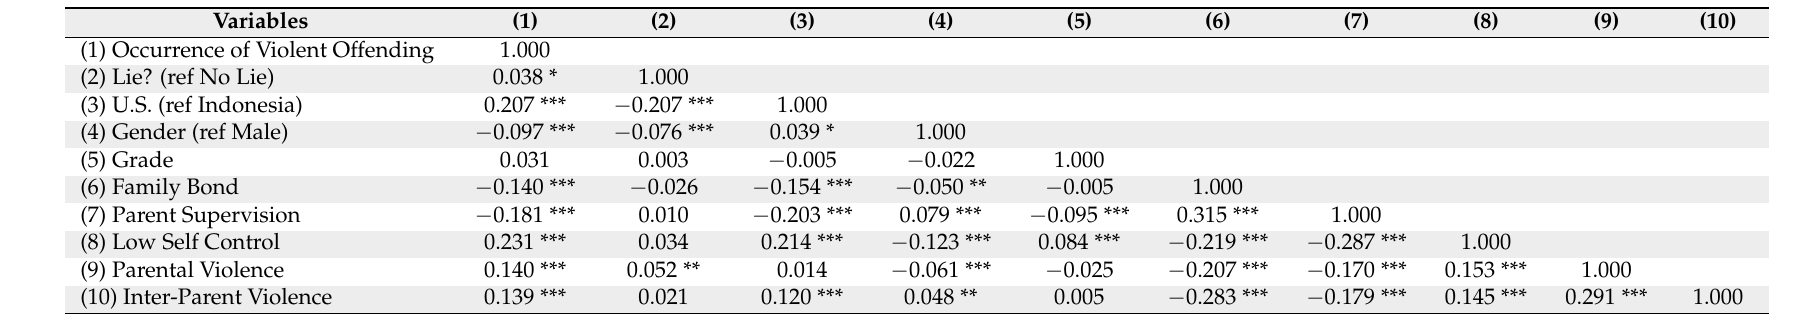
Table 2. Correlation Matrix for Key